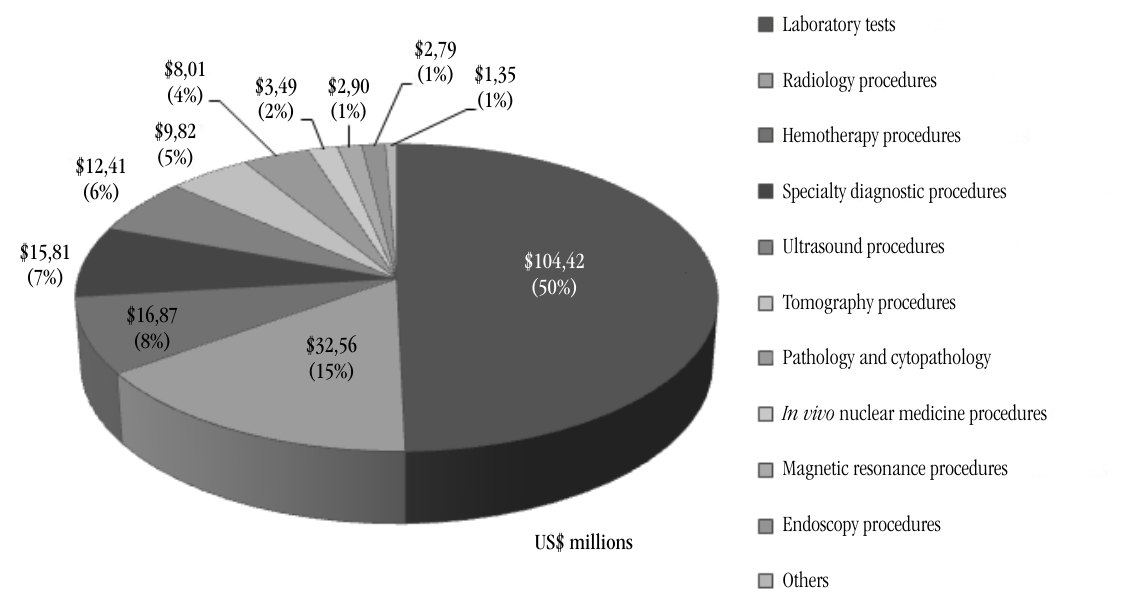
figurE 3 – Distribution of SUS expenses according to the type of outpatient diagnostic procedure in Minas Gerais, 2011 (US$ million) Source: DATASUS, 2012 (12) .